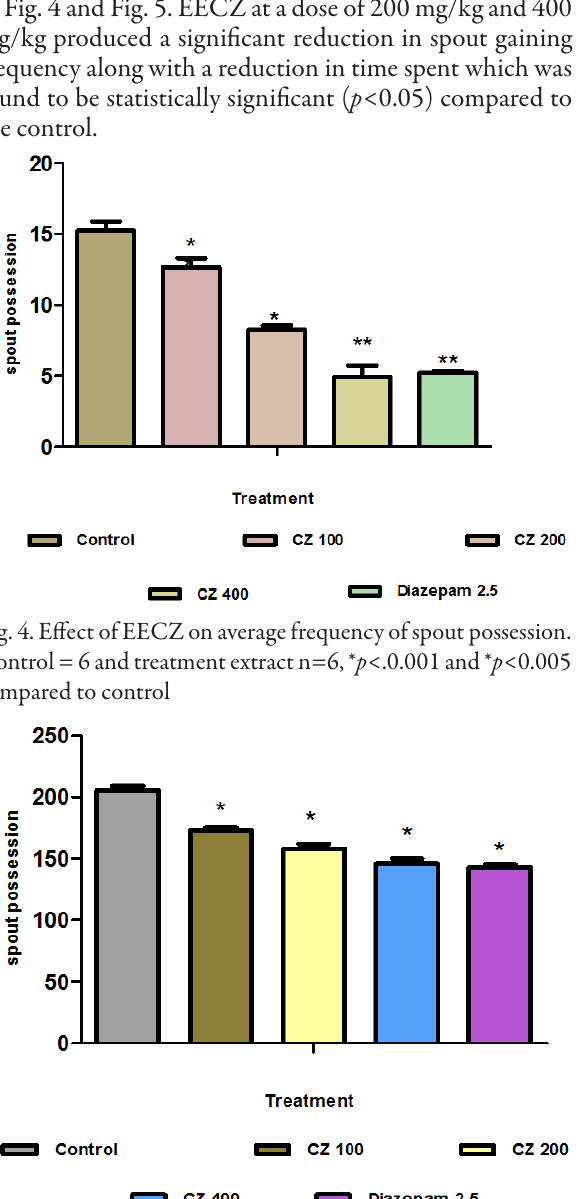
Fig. 5. Effect of EECZ on average time of the spout possession. Control = 6 and treatment extract n=6, * p <0.001 as compared to control